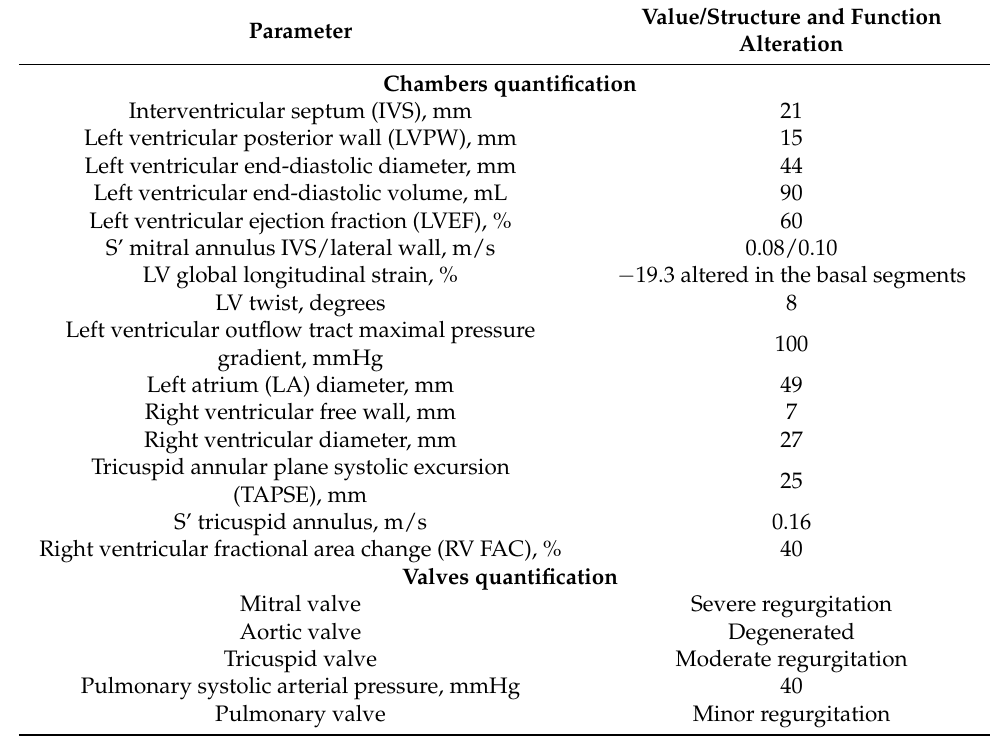
Table 1. Presentation of the transthoracic echocardiographic parameters. Value/Structure and Function Parameter Alteration Chambers